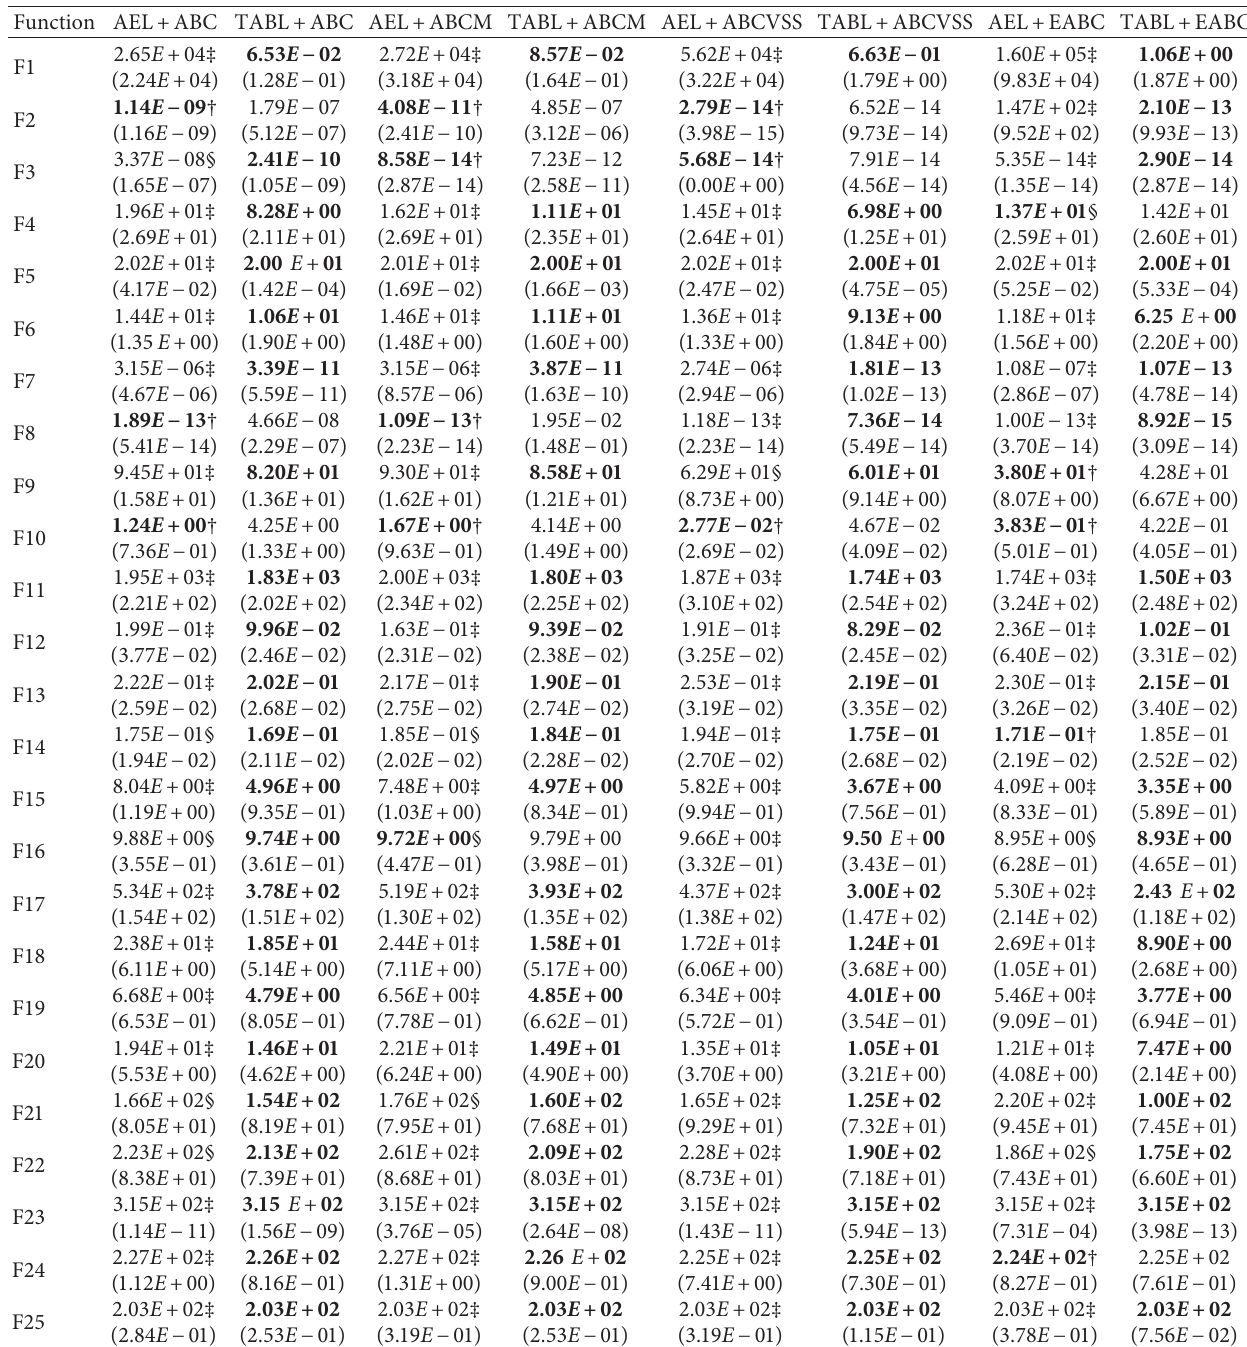
Table 2: The statistical results (mean (Std)) of AEL +ABC vs . TABL +ABC, AEL+ABCM vs. TABL+ABCM, AEL +ABCVSS